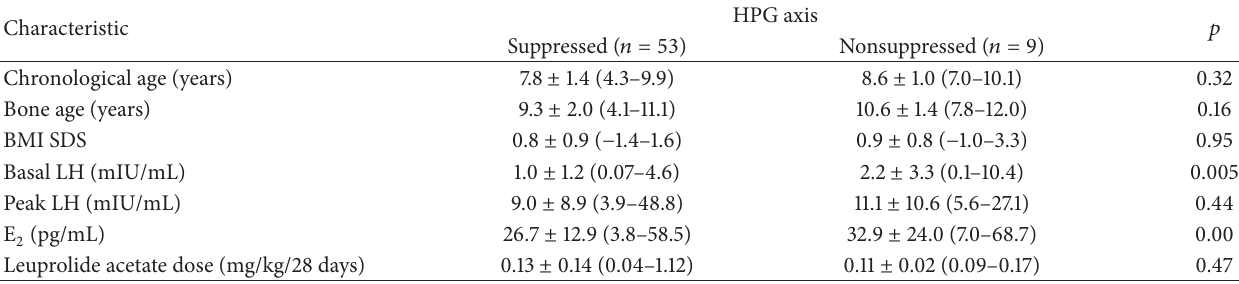
Table 5: Characteristics of patients with and without HPG axis suppression (mean ± SD)